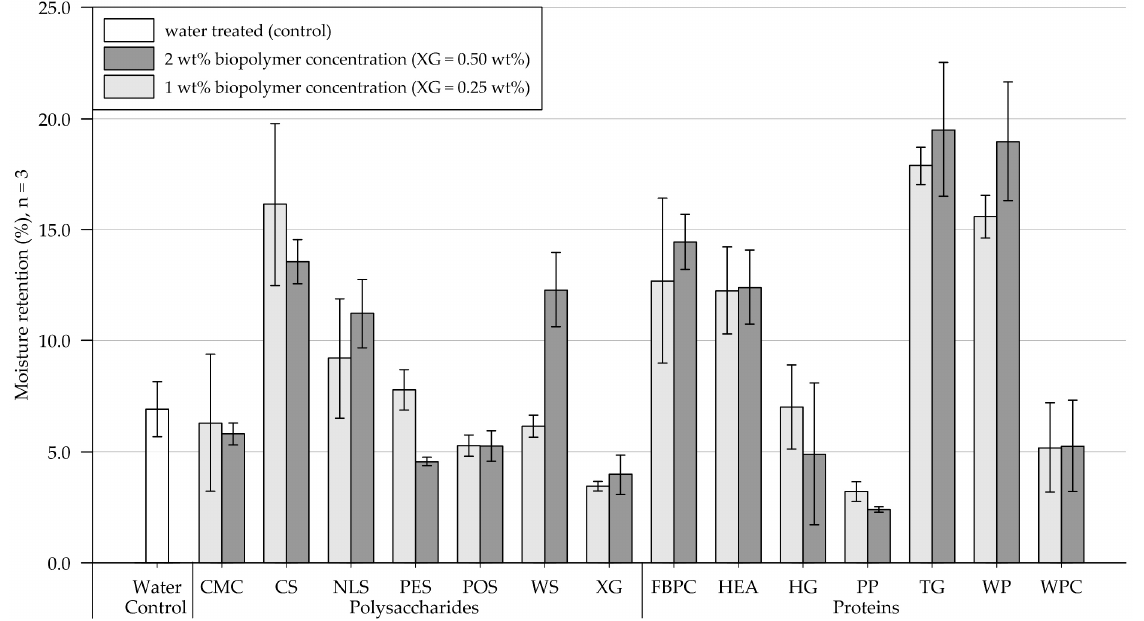
Figure 5. Mean moisture retention of medium-grained sand samples 4 days (96 h) after treatment at 1.6 L/m² and biopolymer concentrations of 1 and 2 wt% (XG = 0.25 and 0.50 wt%). Biopolymers are grouped into polysaccharides and proteins with water as control. Tests were performed in triplicates ( n = 3), and error bars indicate the standard deviation (SD). Note. The exact values of experimental results are appended in Table A2.